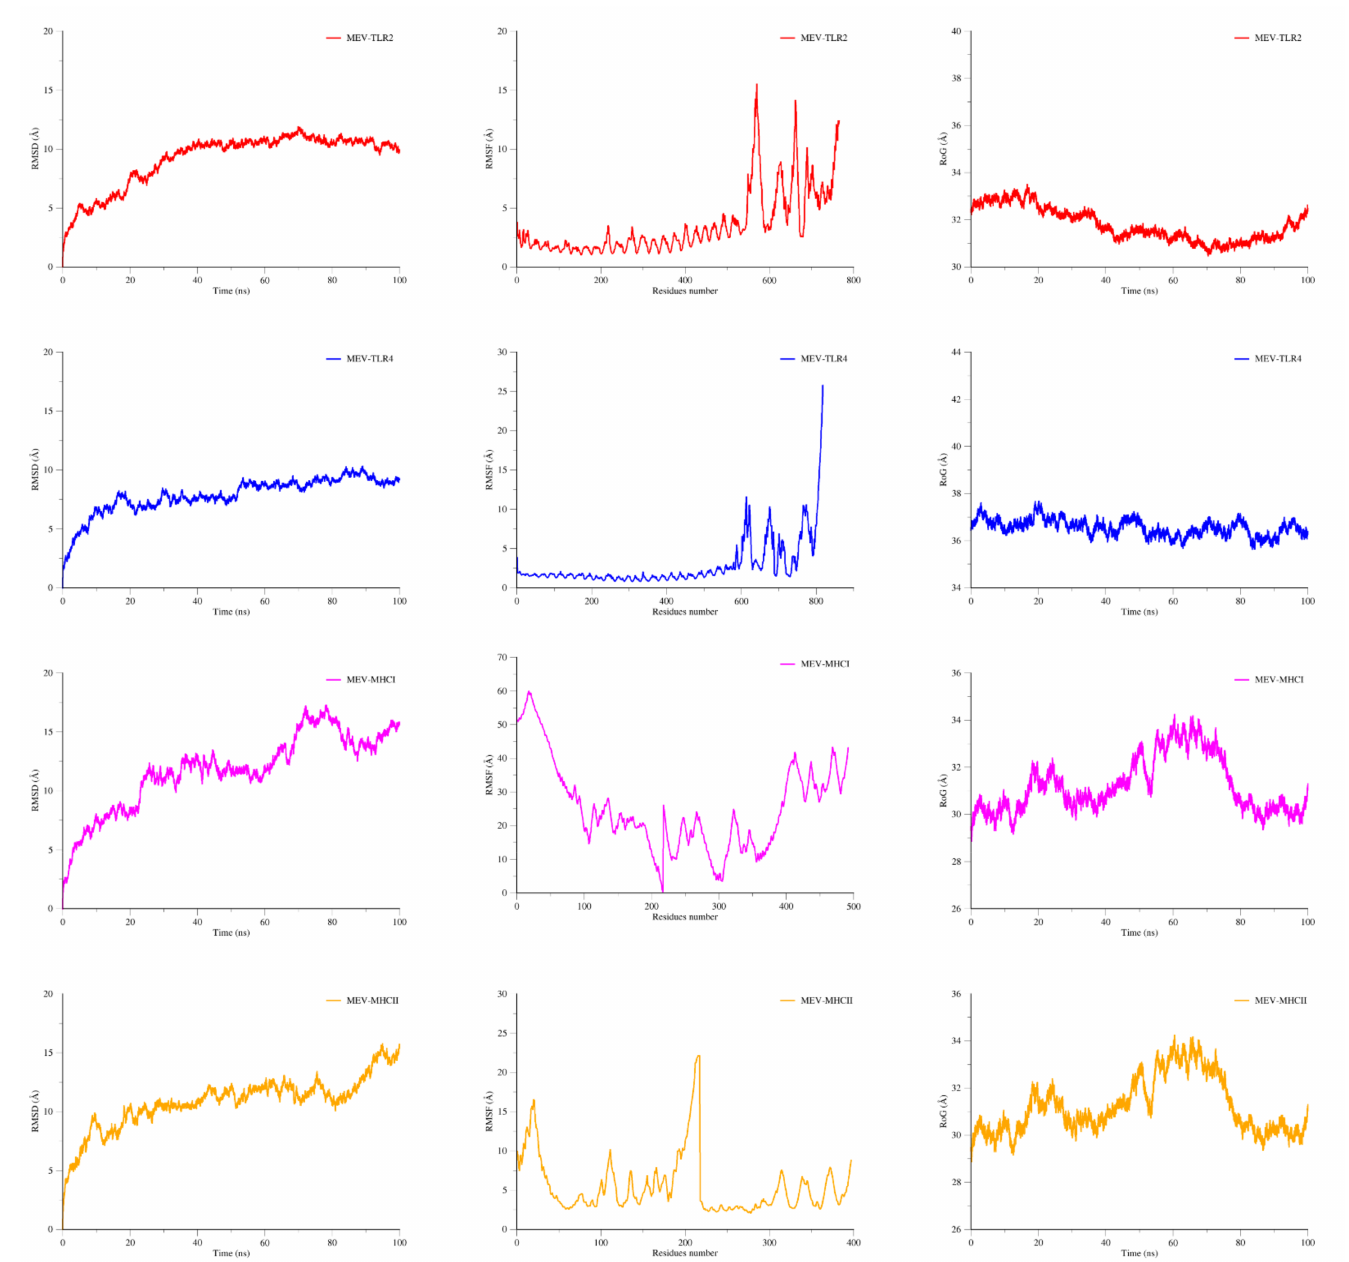
Figure 4. Molecular dynamics simulation-based statistical analysis to evaluate the intermolecular stability and dynamics of the